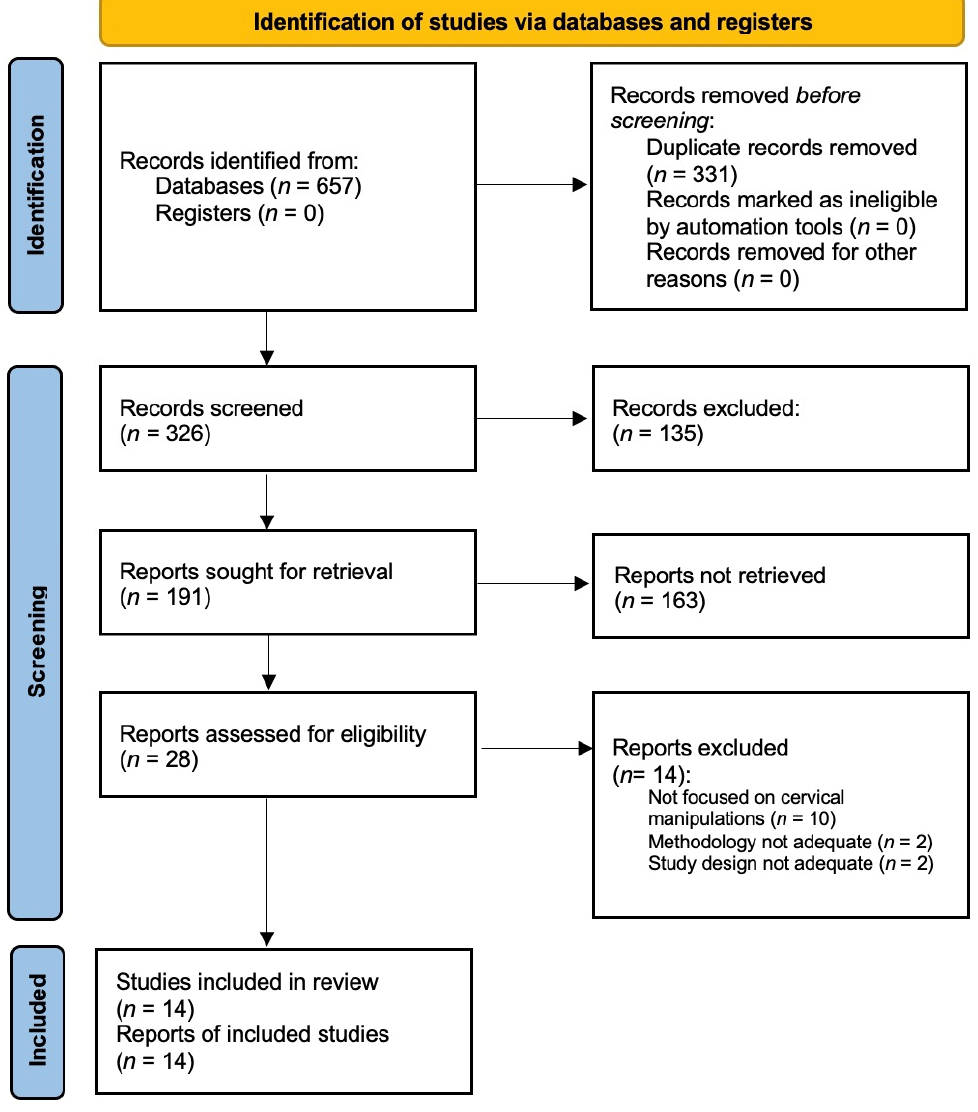
Figure 1. PRISMA 2020 Flow Diagram.